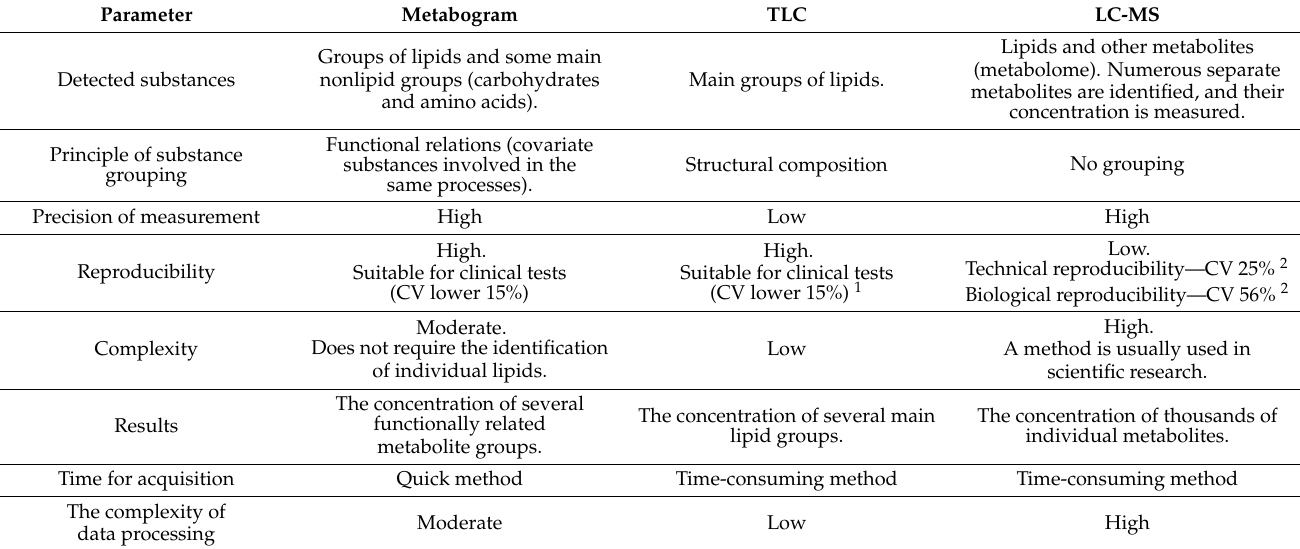
Table 3. Comparative characteristics of mass spectrometric blood metabogram, TLC of blood lipids, and LC-MS analysis of blood